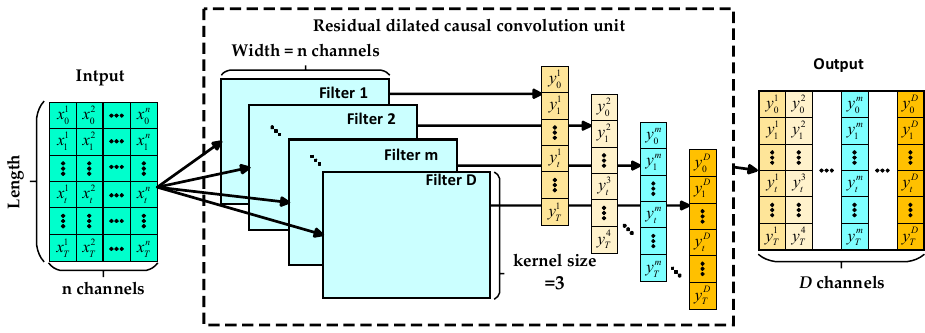
Figure 6. An illustration of the inputs and outputs of one residual dilated causal convolution unit.